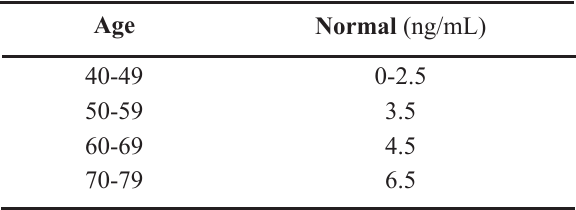
Table 2 – Age-specific PSA